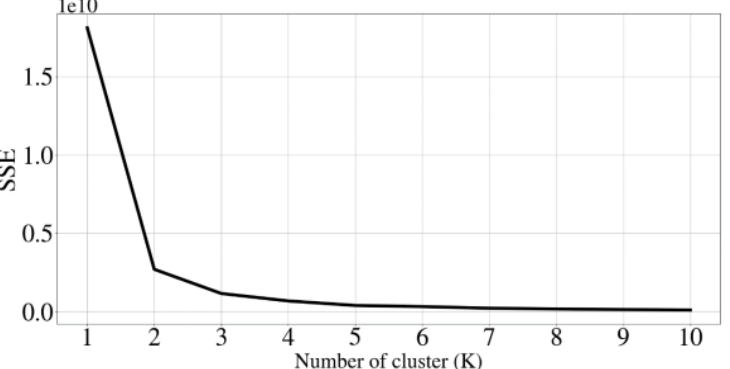
Figure 9. The elbow curve for collected wind power data.